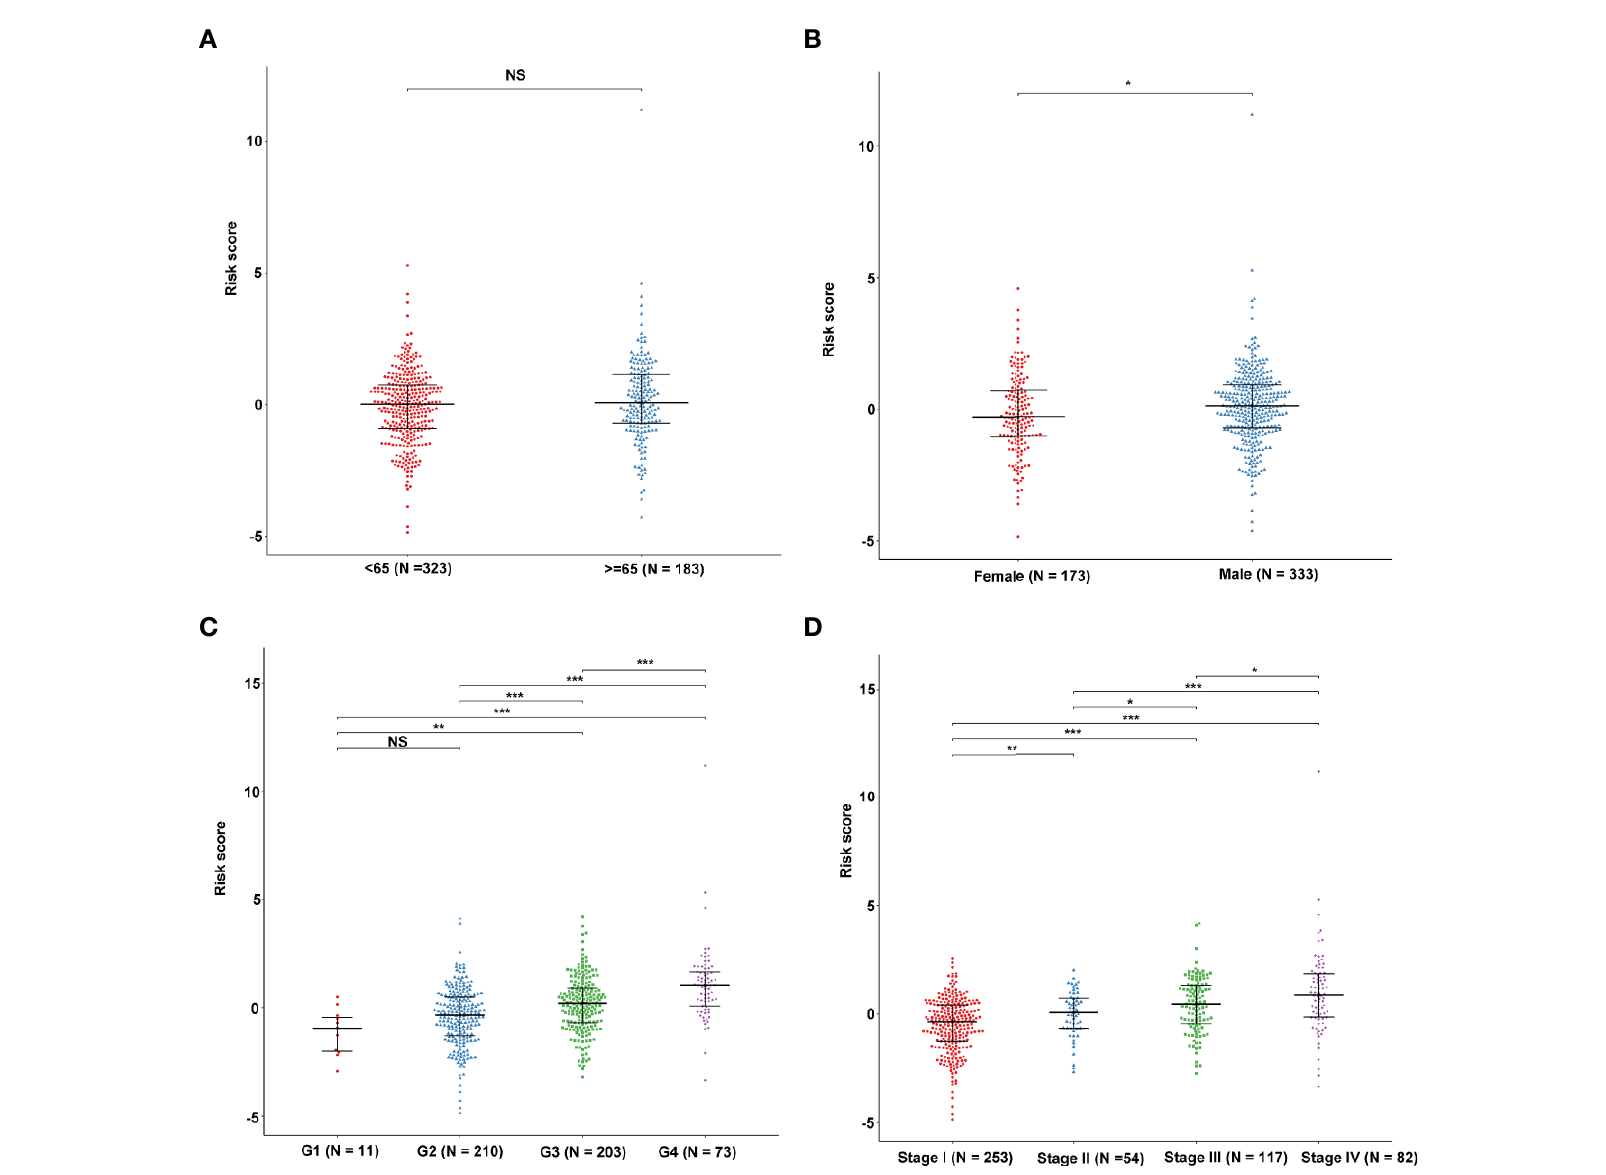
FIGURE 6 | The association between EMT-related signature risk score and clinical factors, including age (A) , gender (B) , grade (C) , stage (D) . NS: Not Signi fi cant, *: P < 0.05, **: P < 0.01, ***: P <